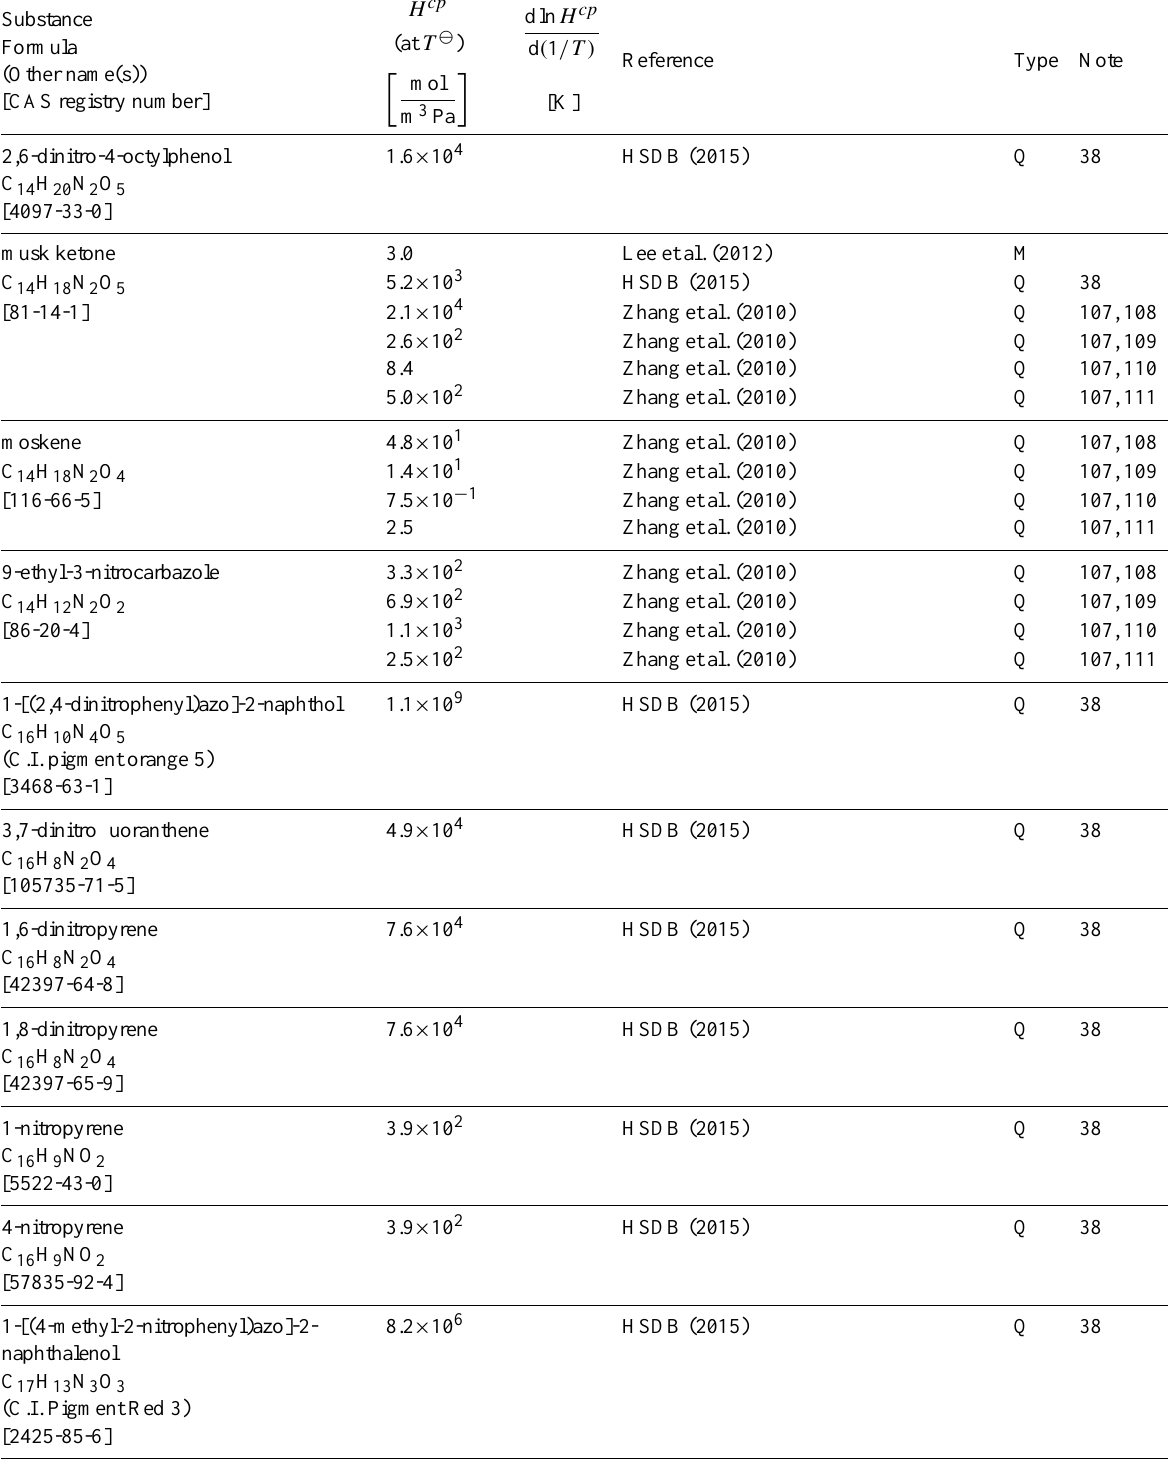
Table 6: Henry’s law constants for water as solvent